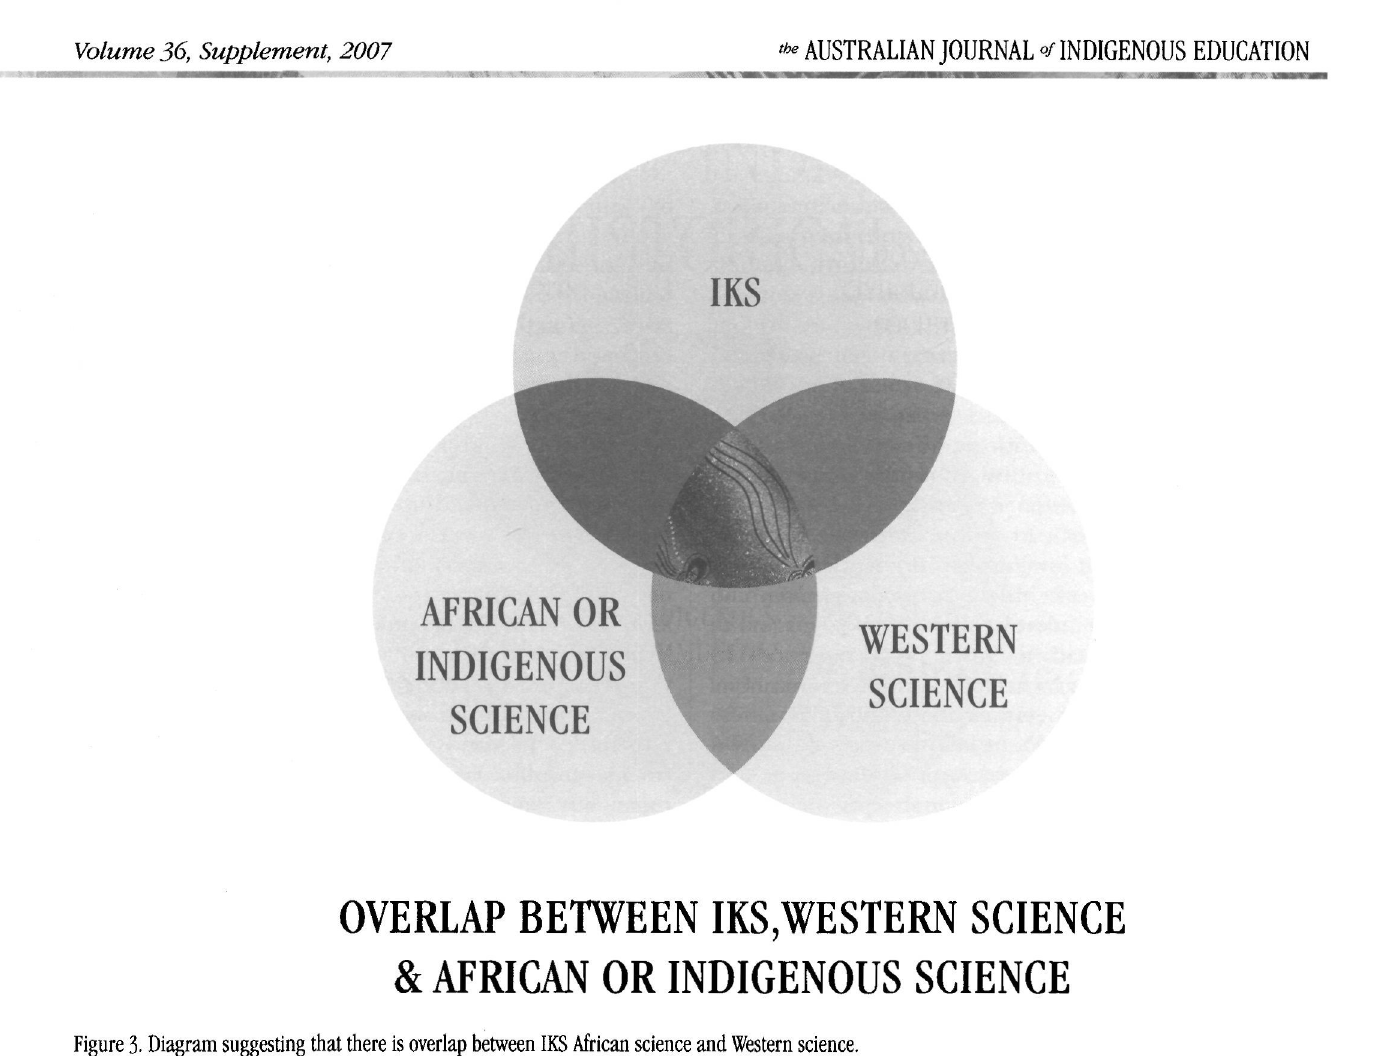
Figure 3. Diagram suggesting that there is overlap between IKS African science and Western